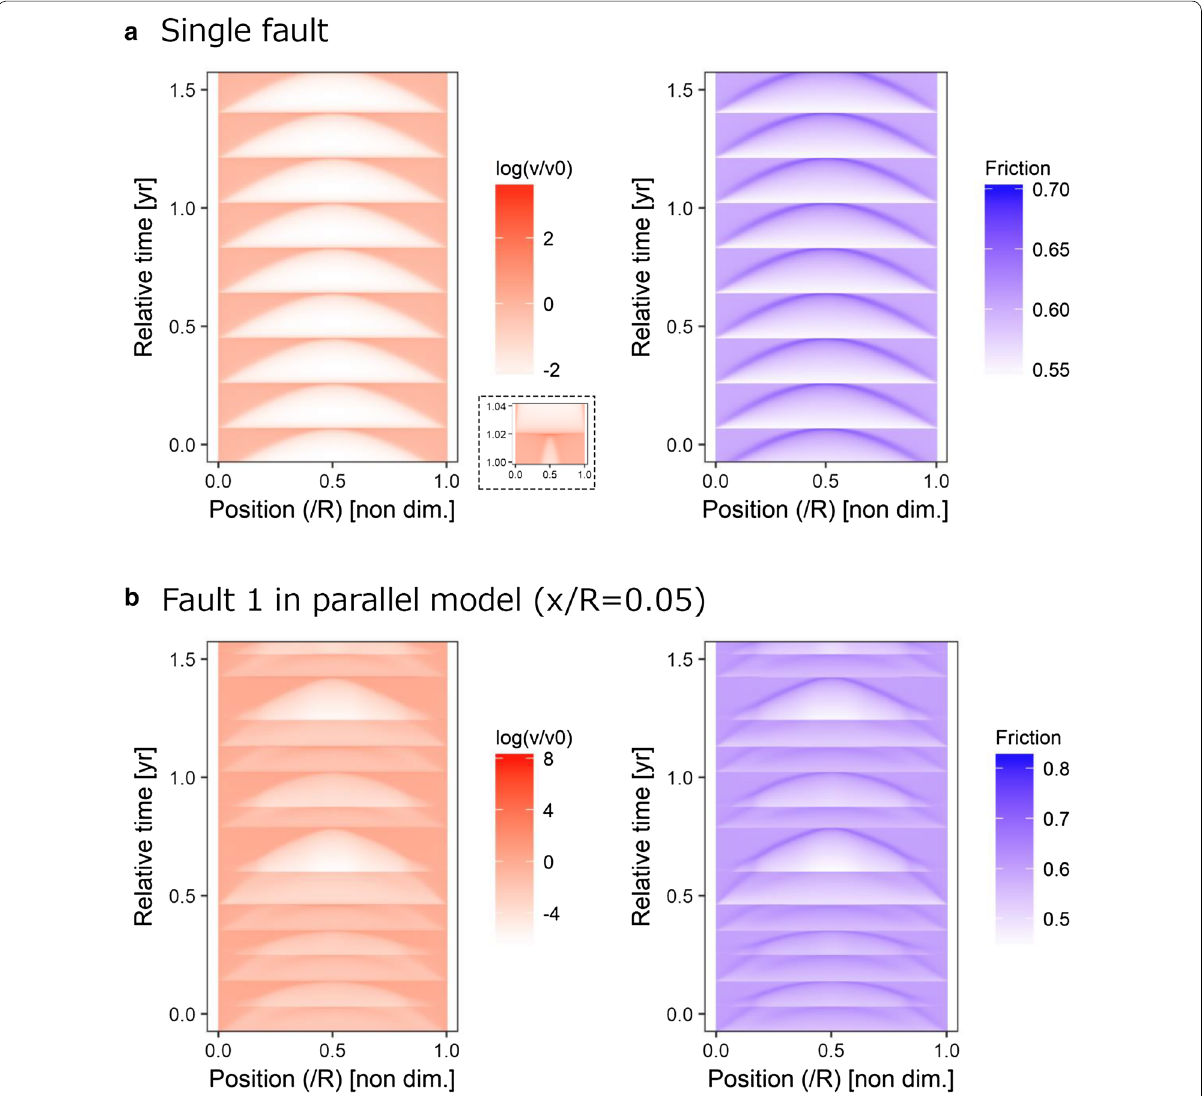
Fig. 2 Spatiotemporal evolution of the common logarithmic slip rate log( v / v 0 ) and the frictional coefficient μ during multiple stick–slip sequence, in Case 2 with the aging law. The horizontal axes are normalized fault position, and the vertical axes are relative time. We show the calculation results after many slip events from the initial condition. a In case of the single fault. A small figure surrounded by a dotted line represents an enlarged graph around one slip event. b In case of Fault 1 of the parallel model with x / R =